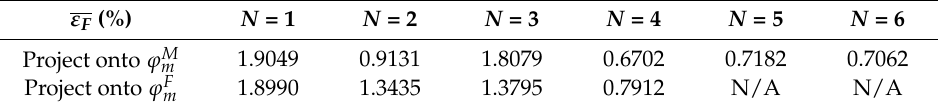
Table 4. Time-averaged error of fracture pressure for different projection operators.